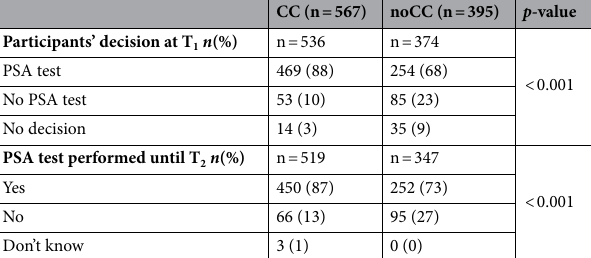
Table 3. Comparison of cost compensation (CC) and no cost compensation (noCC) regarding the decision and performance of a PSA test. T1 two week after consultation, T 2 six months after consultation, PSA prostate specific